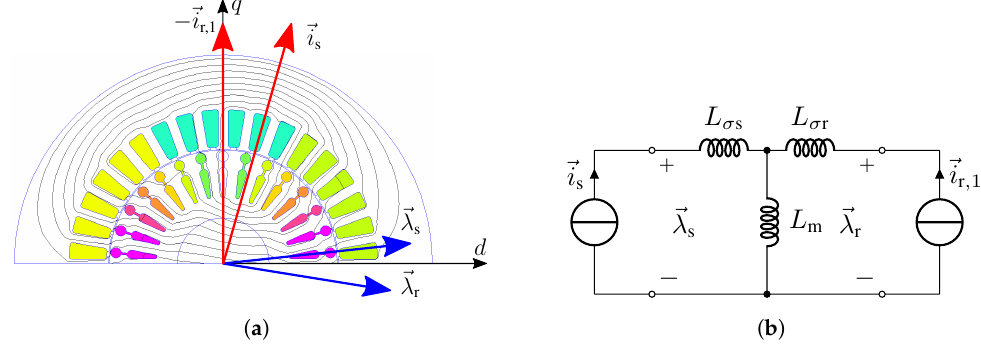
Figure 4. First simulation field solution and related equivalent circuit. The aim of the first analysis is the computation of motor parameters, considering the presence of under-load currents. ( a ) First MS FEA field solution, the imposed current density is shown; ( b ) equivalent circuit related to the first FEA. Stator and rotor leakage and magnetizing indictances are